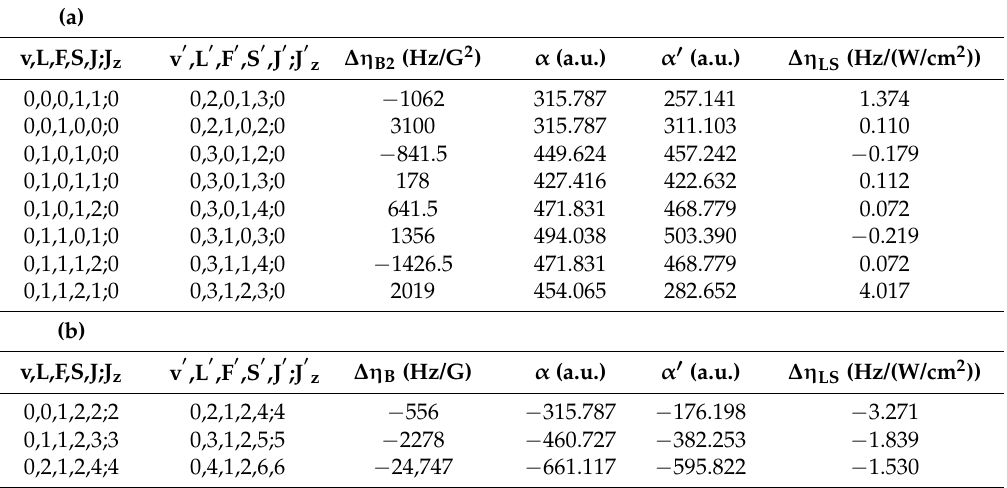
Table 3. Selected hyperfine components of two-photon rotational transitions and estimations